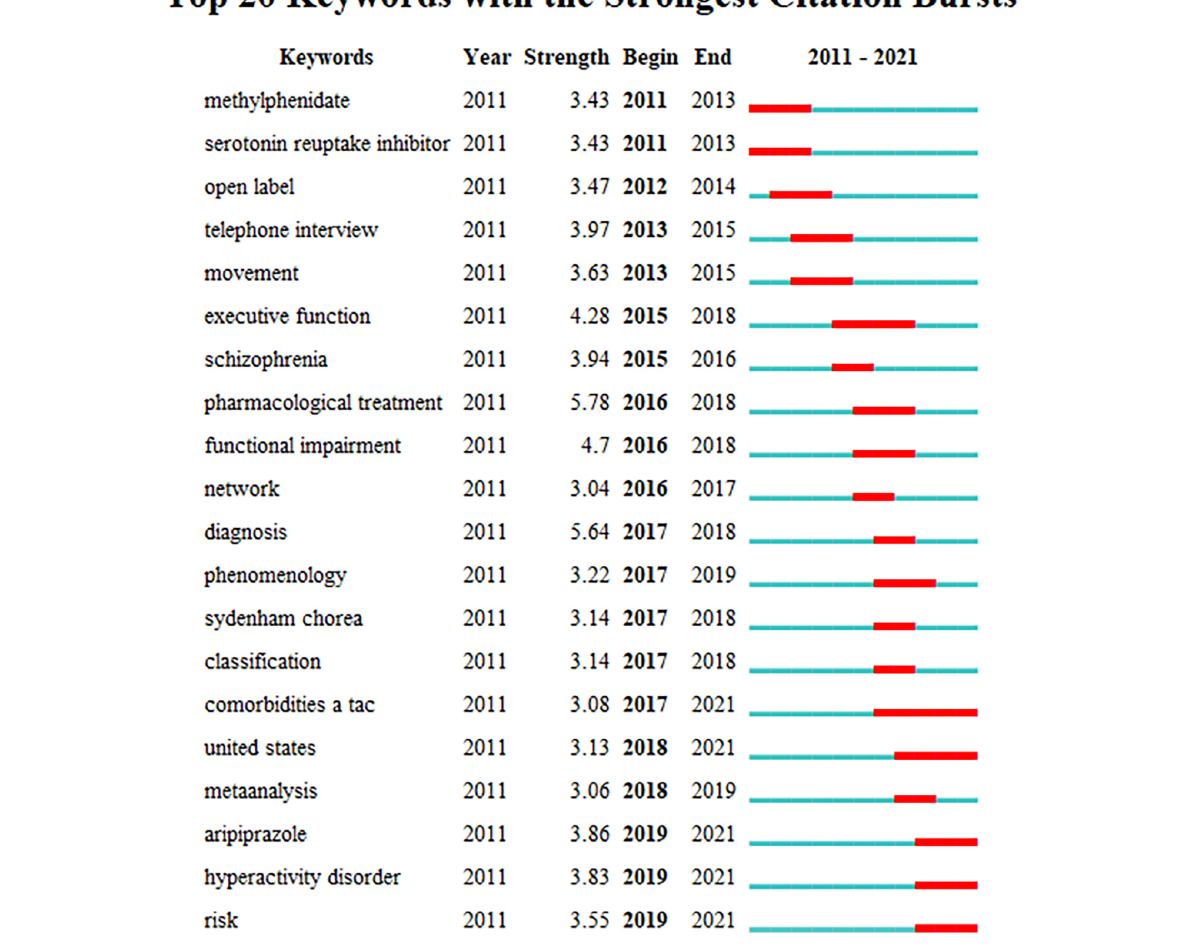
FIGURE7 Top 20 keywords with the strongest citation